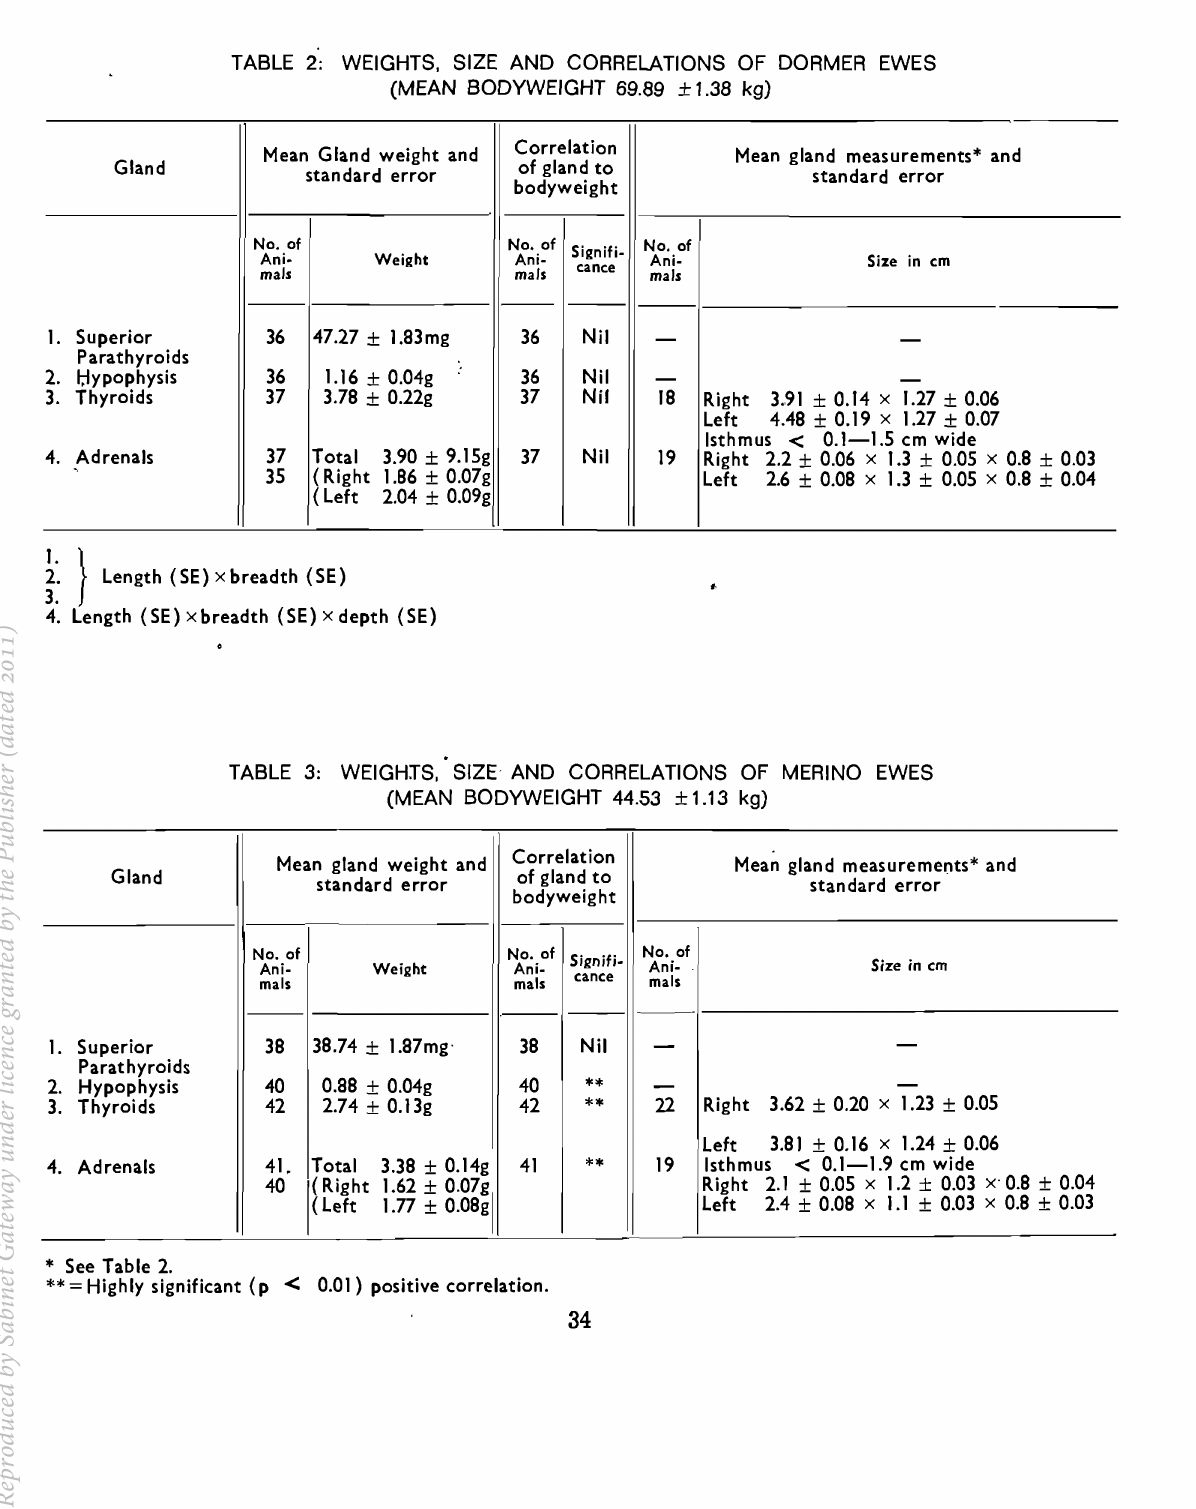
TABLE 2: WEIGHTS, SIZE AND CORRELATIONS OF DORMER EWES (MEAN BODYWEIGHT 69.89 ± 1.38 kg)